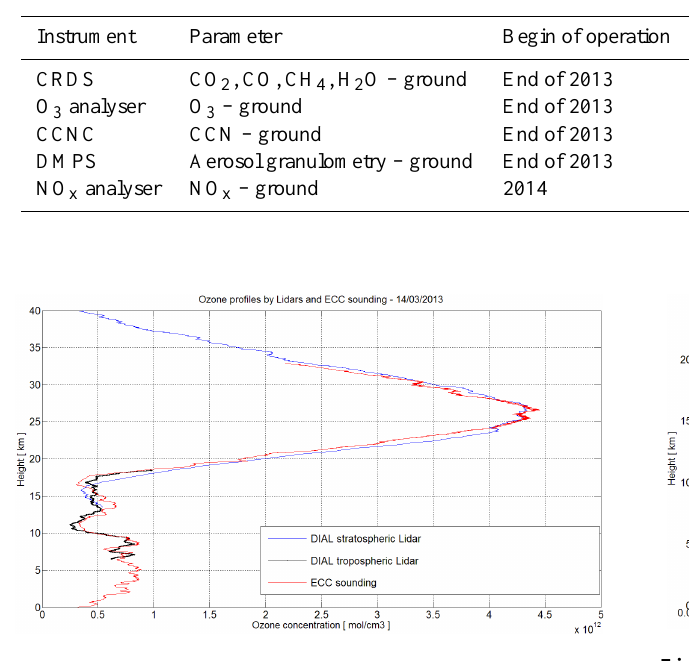
Fig. 4. Ozone profiles on 14 March 2013 by stratospheric DIAL (blue) and tropospheric DIAL (black) at Maïdo, and ozone sonde (red) near the airport.